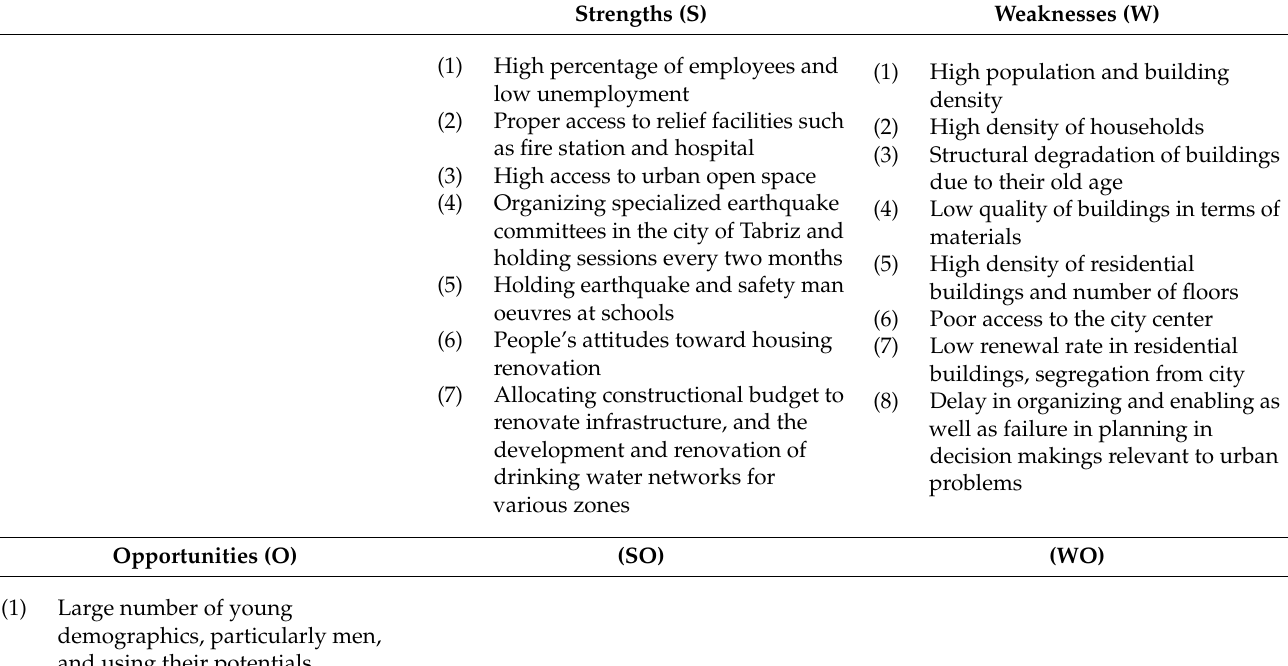
Table 17. Earthquake hazard mitigation strategies in Tabriz, Iran, based on a SWOT